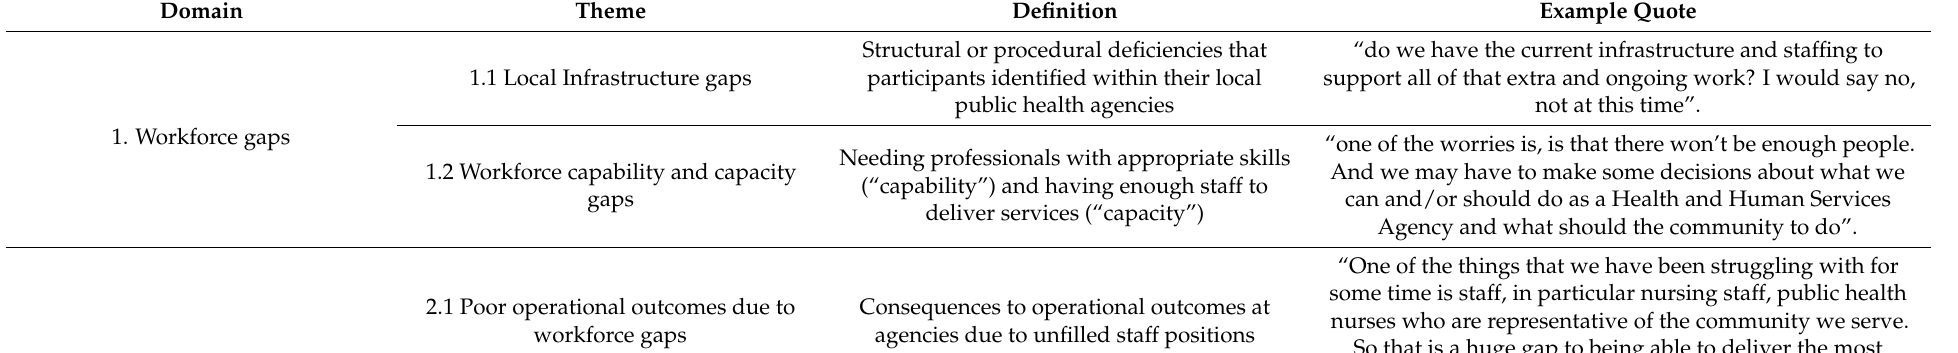
Table 1. Domains, themes, theme definitions, and illustrative quotes. ( n =